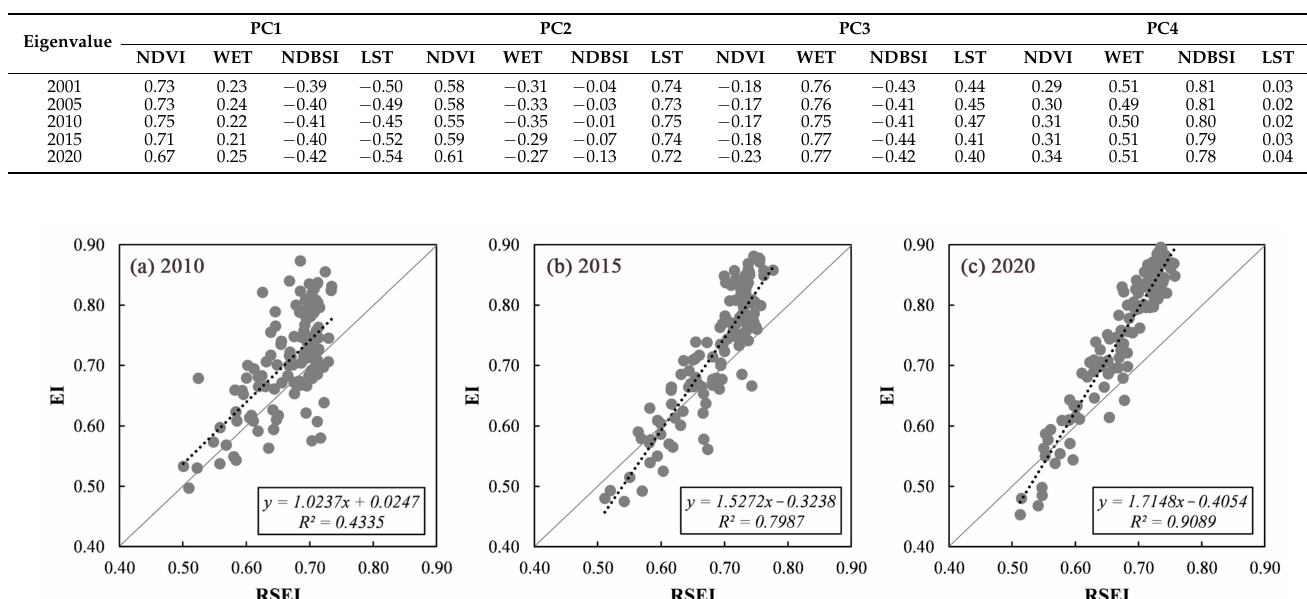
Table 3. Spatial principal component analysis of the RSEI from 2001 to 2020.